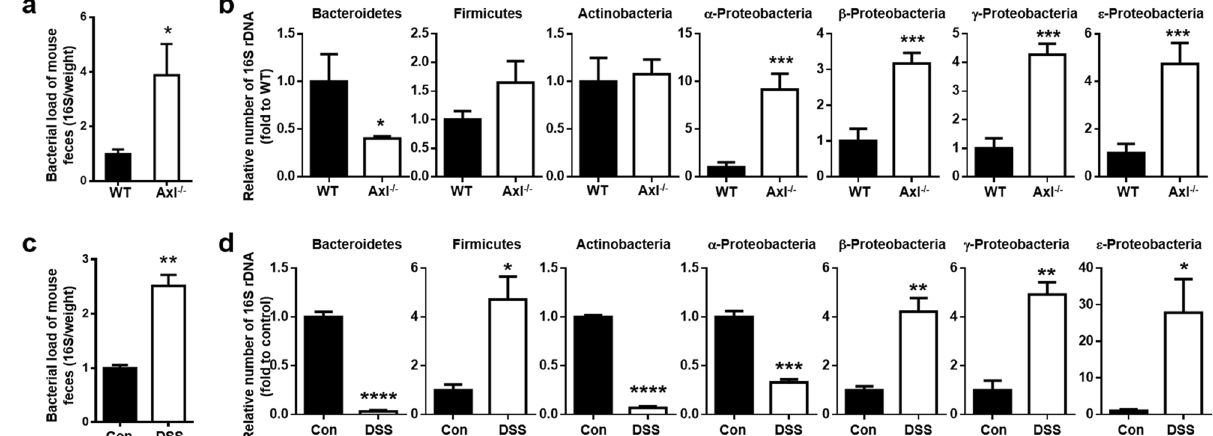
Figure 3. Axl −/− mice showed an abnormal expansion of Proteobacteria. ( a ) Isolation of genomic DNA from feces containing gut microbiota of WT and Axl −/− mice and quantification of bacterial 16S rDNA were described in “Materials and methods”. The bacterial load was assessed by copy numbers of the 16S rDNA gene per milligram of feces. ( b ) The relative numbers of bacteria in each phylum were determined with phylum-specific PCR primer pairs. ( c ) The bacterial load in control and DSS-induced colitis mice. ( d ) The relative numbers of bacteria in control and DSS-induced colitis mice. Data are shown as mean ± SEM. Significance (*p <